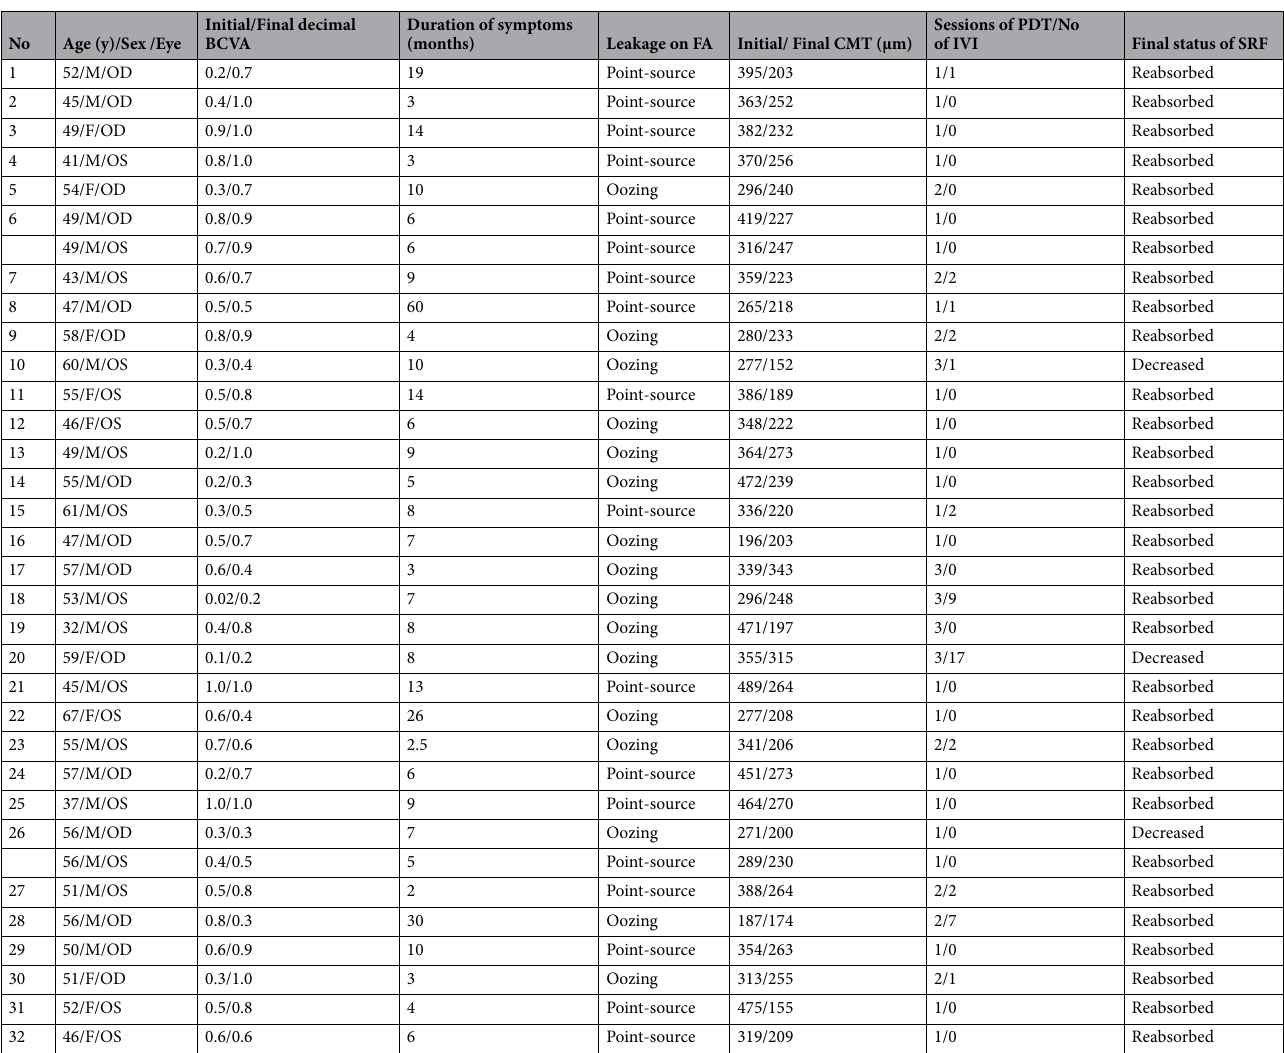
Table 1. Basic demographic data of all patients recruited in this article. BCVA best corrected visual acuity, CMT central macular thickness(um), FA fluoresin angiography, F female, IVI intravitreal injection, M